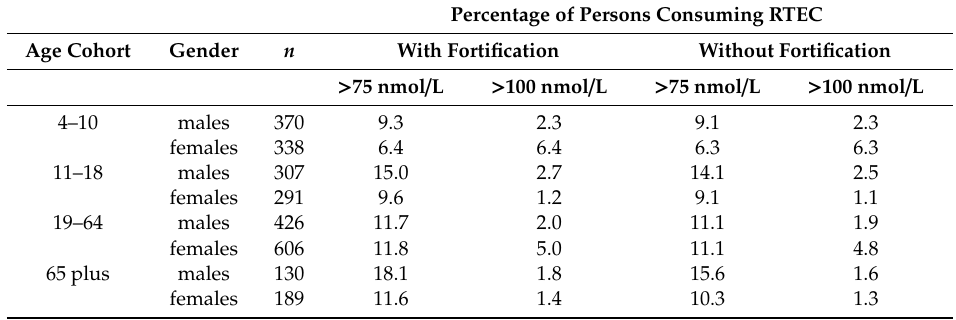
Table 6. The percentage of persons with and without fortification with 4.2 µ g vitamin D per 100 g RTEC above certain threshold levels of 25(OH)D. Results of mathematical modeling. Please note that only RTEC users have been applied. n : total number of